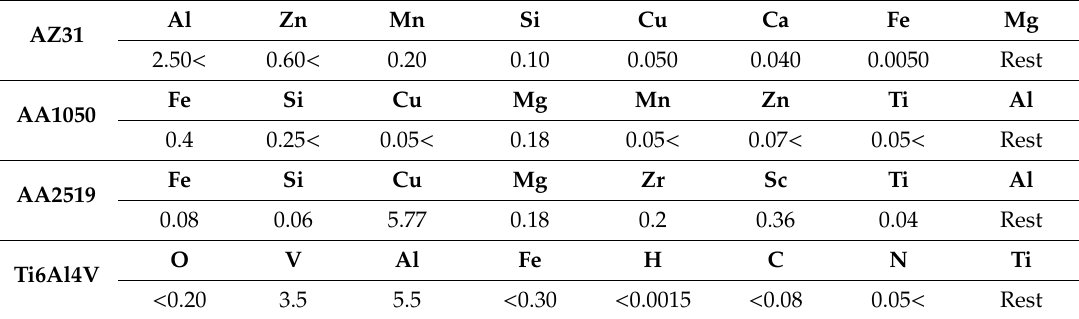
Table 1. Chemical composition of the laminate